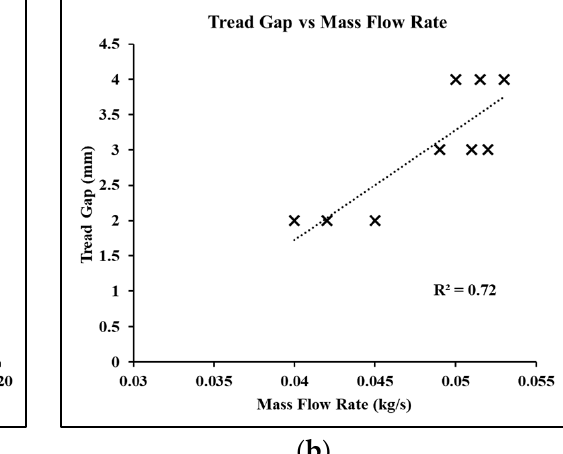
Figure 8. Effect of tread gap on ACOF: ( a ) in dry conditions and ( b ) in wet conditions.